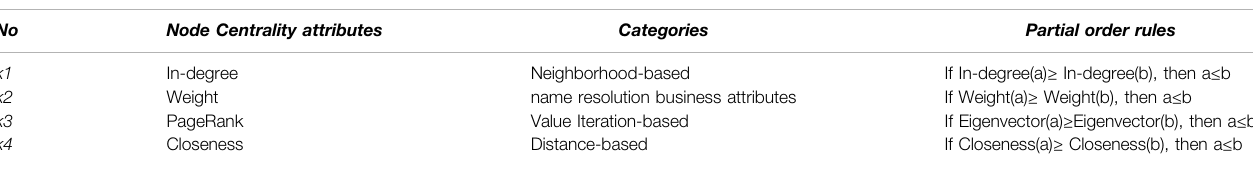
TABLE 2 | Four kinds of node centrality attributes and partial order